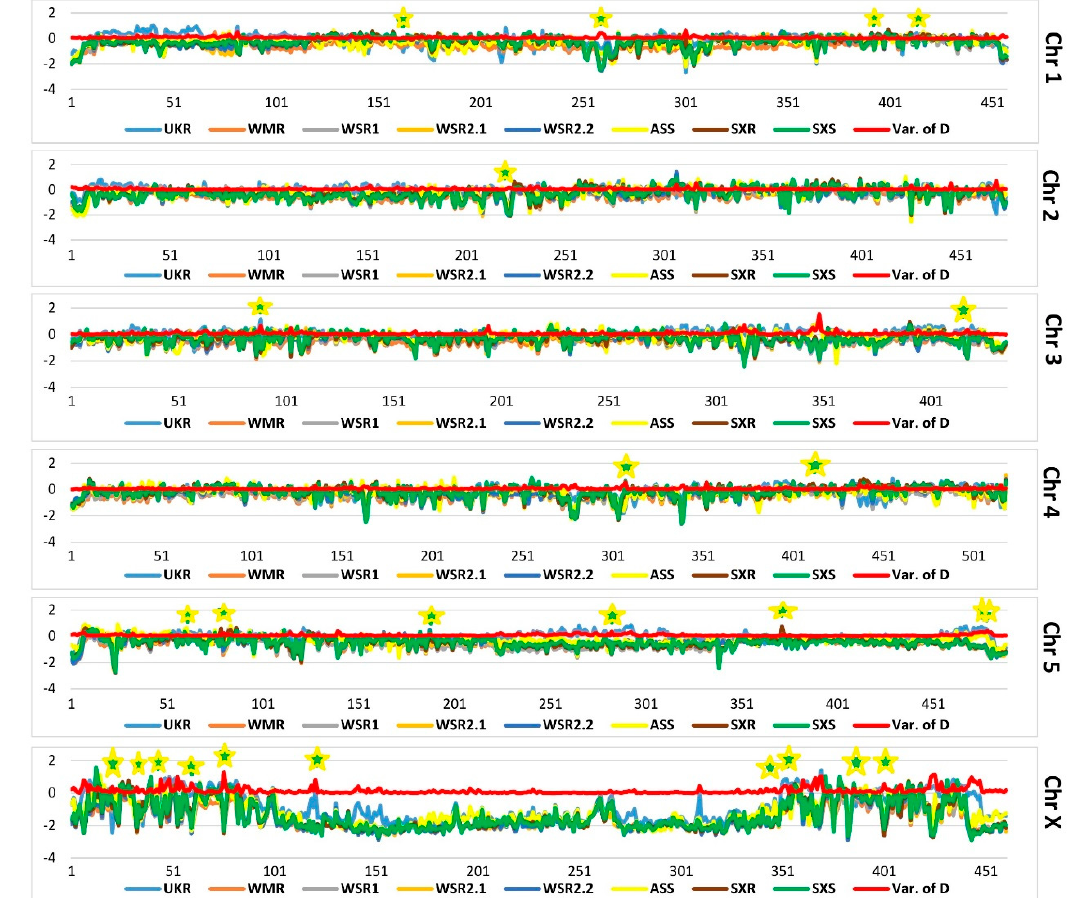
Figure 5. Genome-wide comparison of Tajima’s D across all the strains in the present study. Tajima’s D was calculated in 100 kb windows spanning the genome, and data was mapped chromosome wise. To emphasize the fluctuation in the allelic frequencies across the chromosomes, the variance in the mean value of Tajima’s D was calculated across the pooled data of all the populations, and mapped along with the respective chromosomal data (red line). A high variance is expected in the regions that are under the selection.